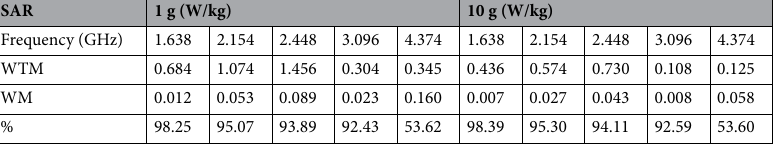
Table 11. 1 g and 10 g SAR results with percentage values for unit cell metamaterial. WTM without metamaterial, WM with metamaterial.